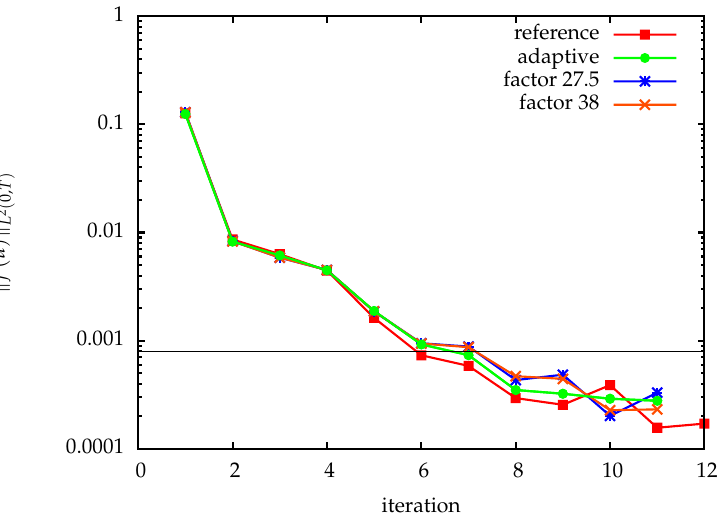
Figure 7. Optimization progress of Broyden, Fletcher, Goldfarb, and Shanno (BFGS) for the monodomain example (9), (10), using different quantization tolerances for the state trajectory. No delta-encoding between timesteps was used. The horizontal line shows the approximate discretization error of the reduced gradient. See also